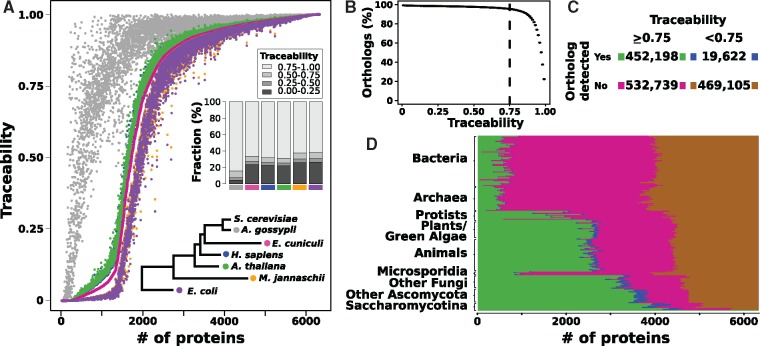
—The evolutionary traceability of yeast proteins. (A) Traceability indices for 6,352 yeast proteins in Ashbya gossypii (Fungi), Encephalitozoon cuniculi (Microsporidia), Homo sapiens (Metazoa), Arabidopsis thaliana (Viridiplantae), Methanocaldococcus jannaschii (Archaea), and Escherichia coli (Bacteria). Proteins are ordered according to their traceability index in E. cuniculi. The inlay shows a stacked bar plot providing, for each species, the fraction of proteins in each of the four traceability bins. The color code identifying the individual species is specified in the phylogenetic tree. (B) Cumulative distribution of the detected yeast orthologs relative to the protein's traceability index. Of the detected orthologs, 95% coincide with a traceability index of 0.75 or above in the respective species (hatched line). (C) Relation between results of the ortholog search and protein traceability. (D) Per-species results with the color code following (C).